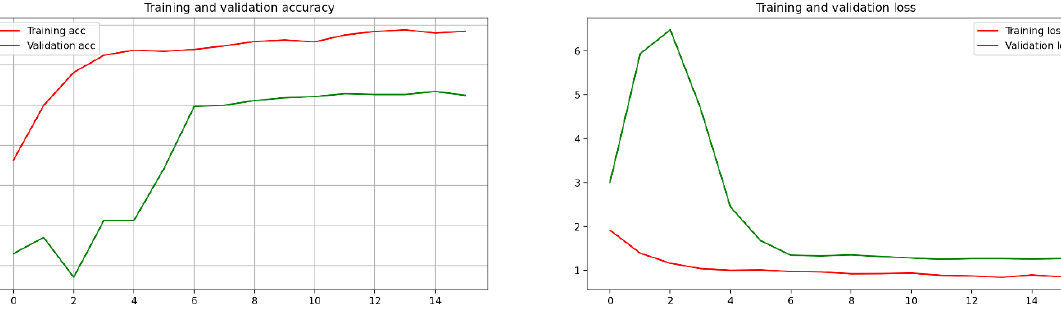
Figure 7. The plots of convergence for the comparison model.